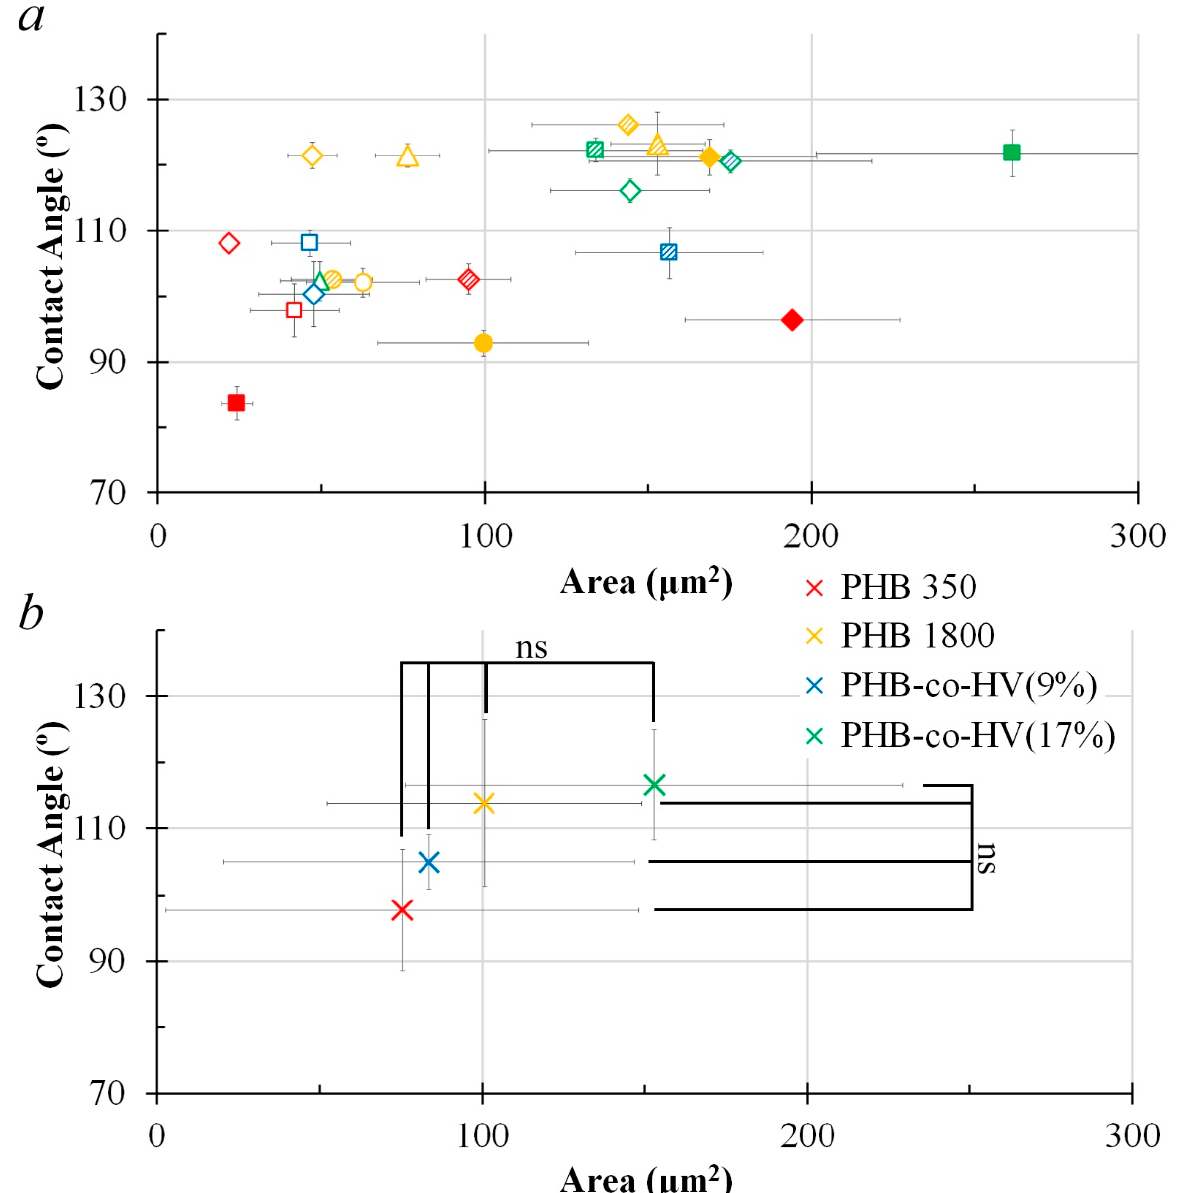
Figure 10. Area vs. Contact Angle plot of structural elements based on their respective concentrations and volumes (150 μ L, 300 μ L, 450 μ L) with the distance L = 3 cm (n = 13). Legends: Polymers: red—PHB 350 kDa; yellow—PHB 1800 kDa; blue—PHB- co -HV (9%); green—PHB- co -HV(17%). Concentration: ◯ —5 mg/mL; △ —10 mg/mL; ◇ —20 mg/mL; □ —40 mg/mL. Volume: blank marker—150 μ L; shaded marker—300 μ L; filled marker—450 μ L ( a ). Average data for each polymer group PHB350, PHB1800, PHB- co -HV(9%), PHB- co -HV(17%), n = number of data points for each polymer type; ns ( p > 0.05 vs. PHB350) for polymer groups representing area and contact angle, the Kruskal–Wallis one-way ANOVA test for more than 2 independent groups ( b ).